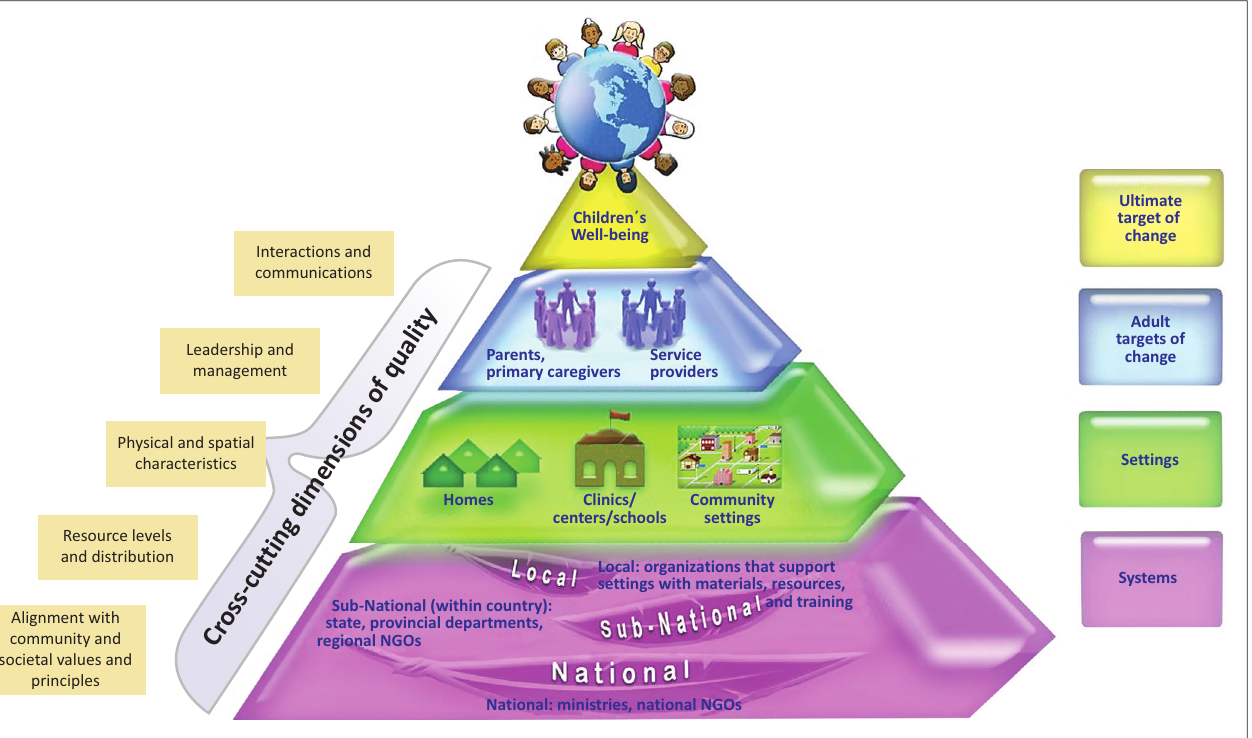
FIGURE 1: Ecological setting and systems levels and cross-cutting